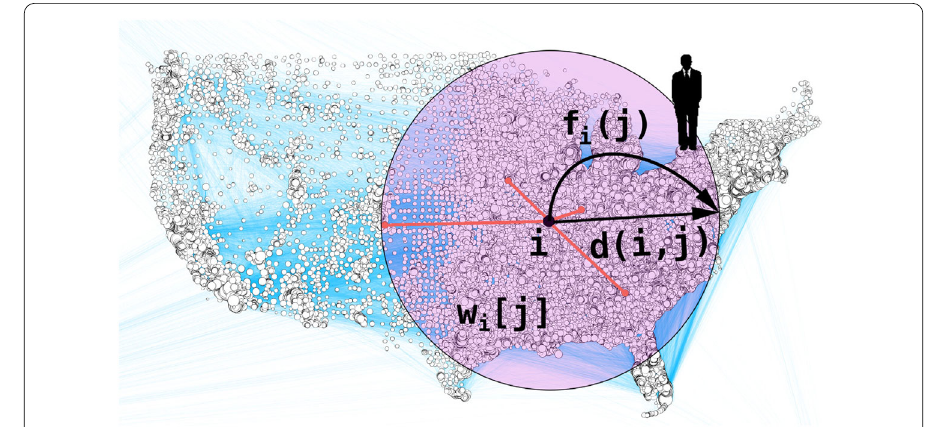
Figure 2 Settlements and data processing method in the commuting network of USA. Disks of different radius d ( i , j ), starting from a given settlement and reaching the other j settlements, are constructed. The population w i [ j ] inside these disks and the commuter number, starting from settlement i and traveling to settlement j ,